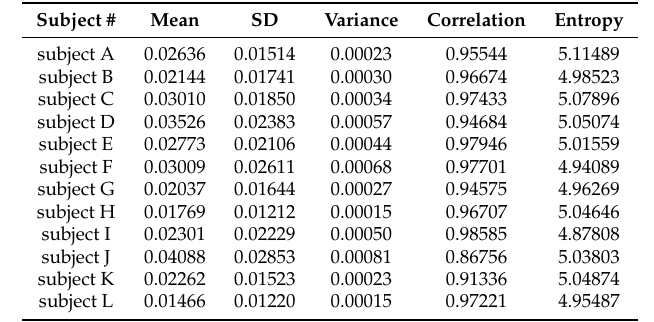
Table 4. Variability of the HISUISUI care home dataset by pre-processing, which is used for clustering. Mean, Standard deviation, variance, auto-correlation, and entropy were calculated according Equations